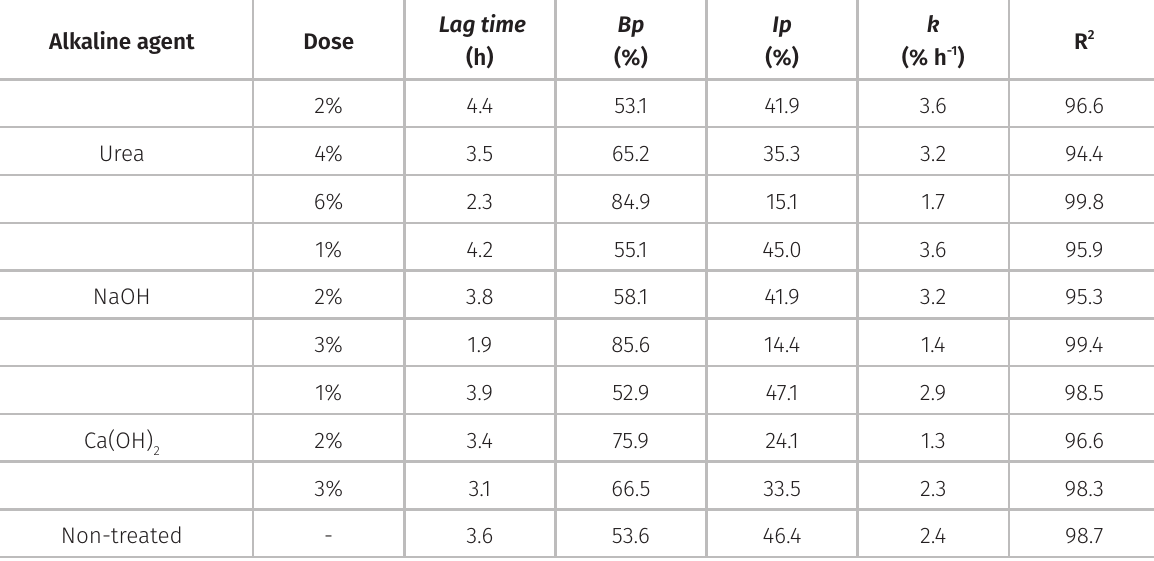
Table IV. Colonization time ( lag time ), standardized potentially degradable fraction ( Bp ), standardized undegradable fraction ( Ip ), rate of passage ( k ), and coefficient of determination for NDF of sugarcane tip hay treated or not with alkaline